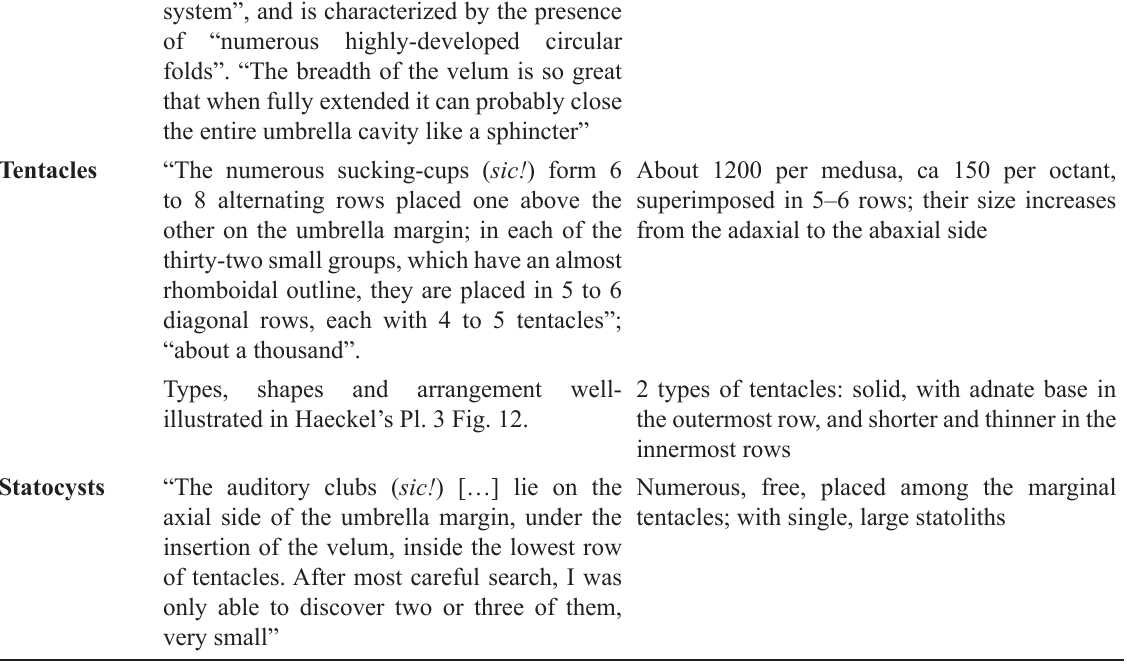
2 types of tentacles: solid, with adnate base in innermost